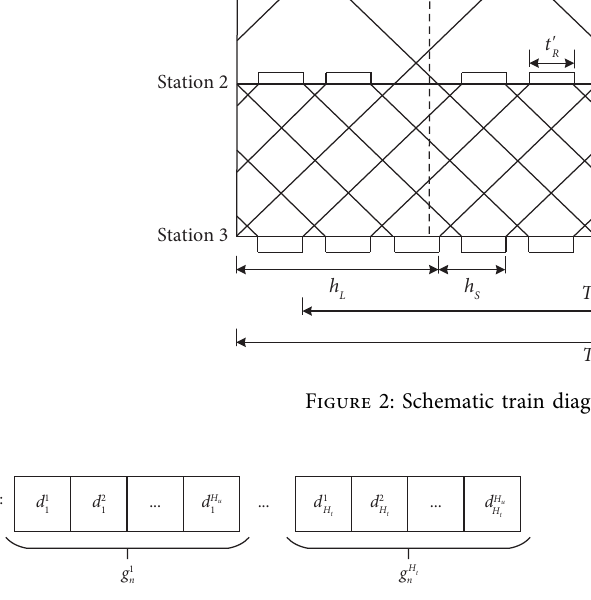
Figure 3: Example of gene